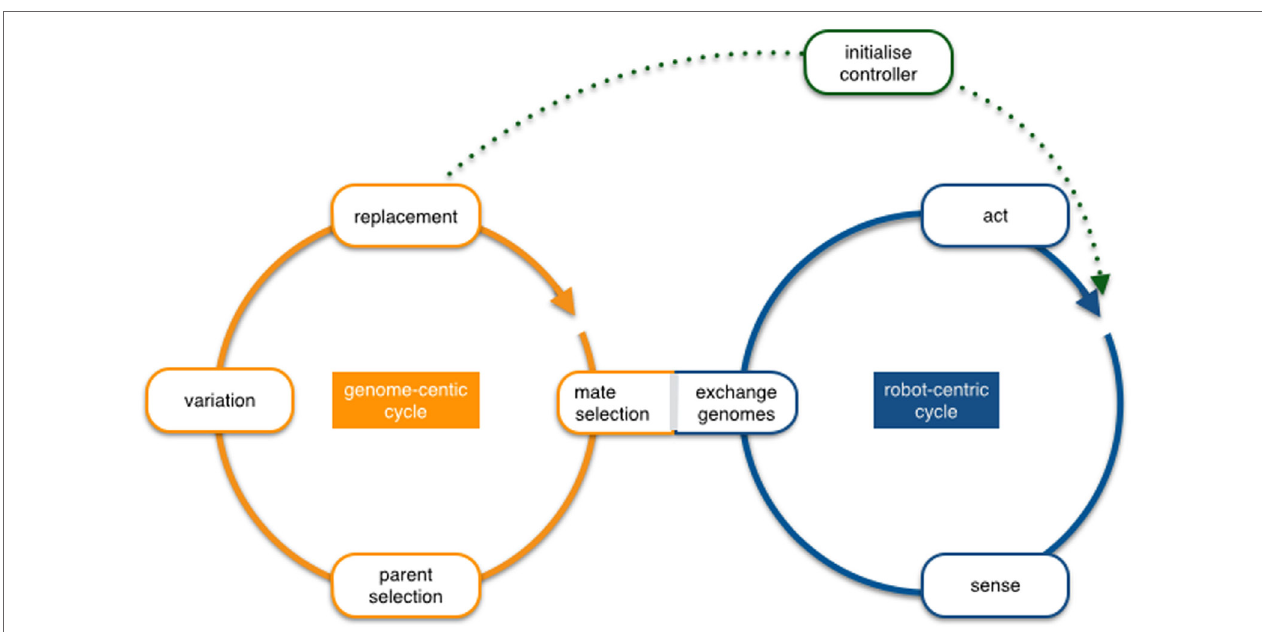
FiGURe 1 | The overlapping robot-centric and genome-centric cycles in embodied evolution. The robot-centric cycle uses a single active genome that determines the current robot behavior (sense–act loop), and the genome-centric cycle manages an internal reservoir of genomes received from other robots or built locally (parent selection/variation), of which the next active genome will be selected eventually